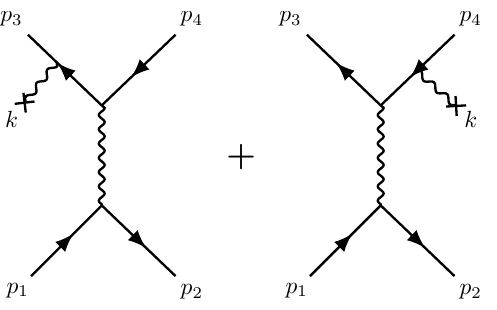
Figure 3. Leading order perturbative contribution to M Y (2.28). Our decomposition groups together the two (cid:12)ve-point diagrams required to maintain gauge